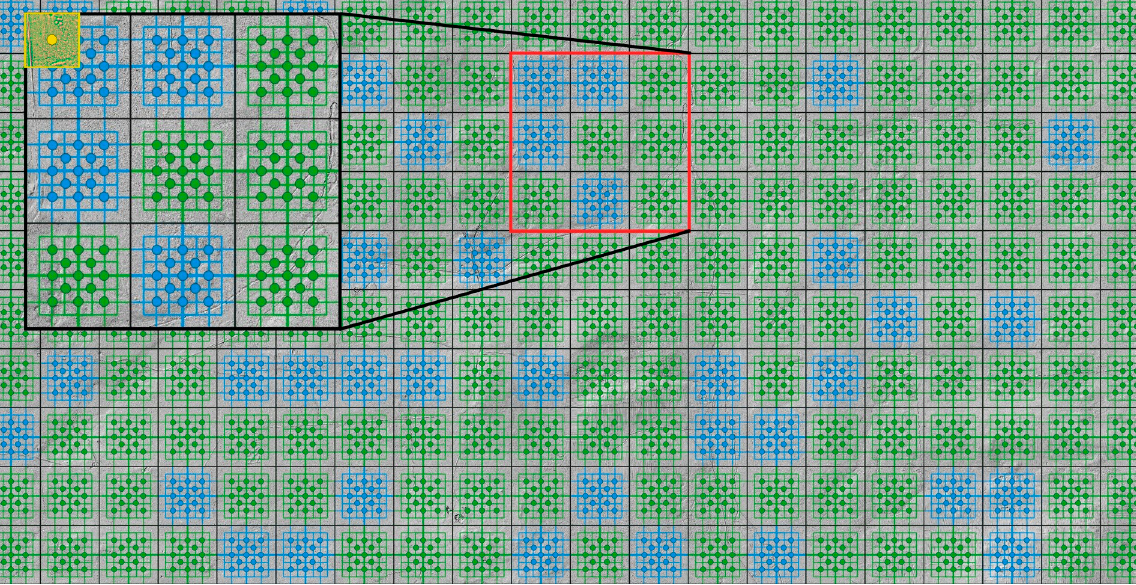
Figure 4. Training dataset preparation—square land section of the training area (5 × 10 kilometres) with randomly generated train/validation sets (green) and test set (blue). Points are the centroids of the generated tiles. Enlarged fragment (red box) and single training image (yellow box with dot).